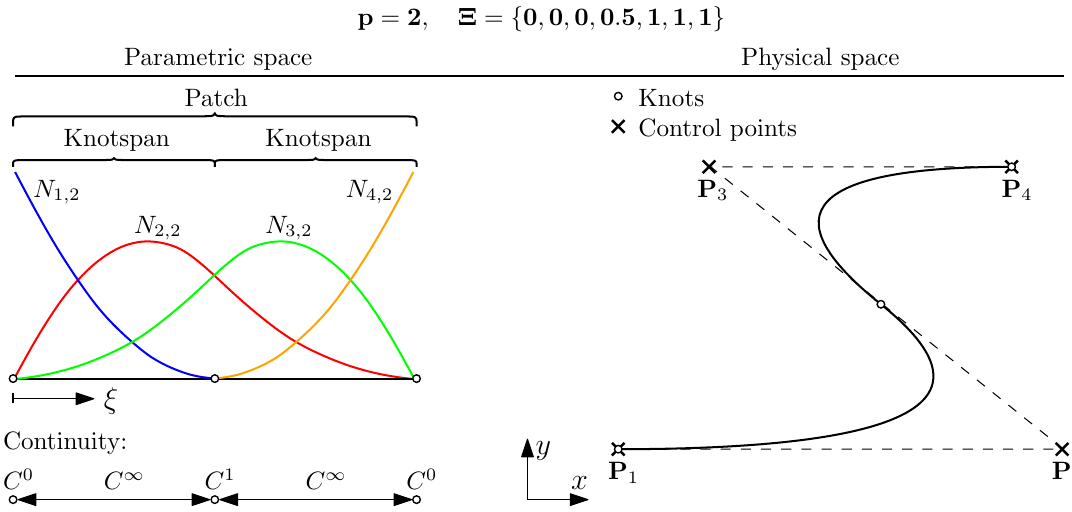
Figure 1. Description of B-spline (NURBS) finite element geometry. The geometry is modeled by one patch consisting of two knotspans with quadratic NURBS